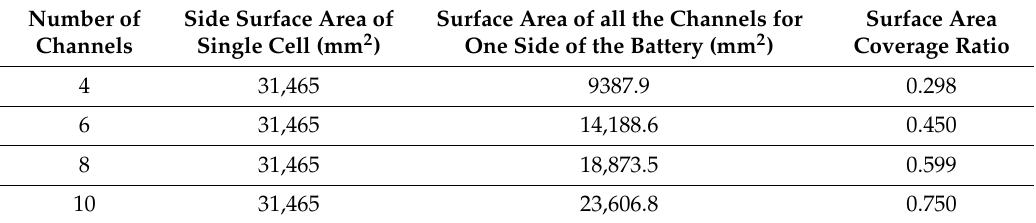
Table 6. Surface area coverage